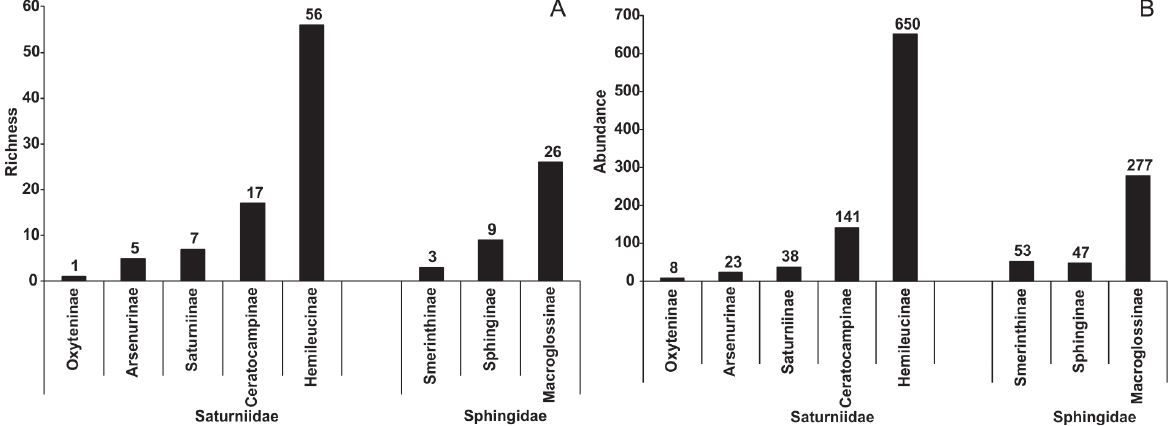
Figure 3 - Species richness (A) and abundance (B) of Saturniidae and Sphingidae by subfamily in Tijucas do Sul, Paraná,